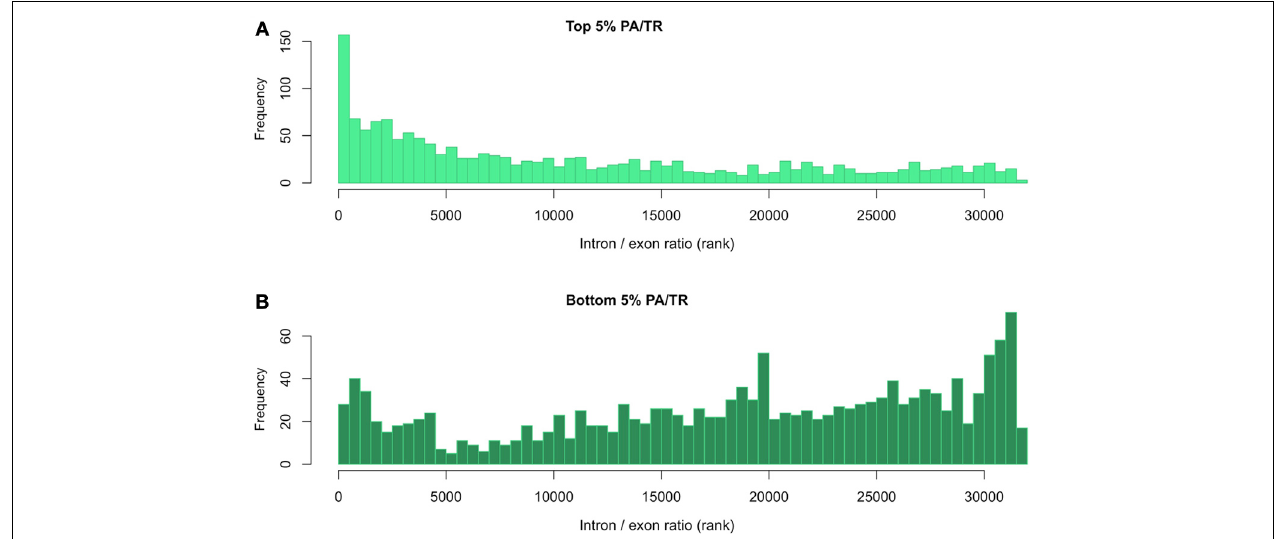
FIGURE 3 | Evaluation of mRNA stability using the relationship between the intronic and exonic signals. (A) Distribution of intron/exon ratio of transcripts with top 5% and (B) bottom 5% PA/TR